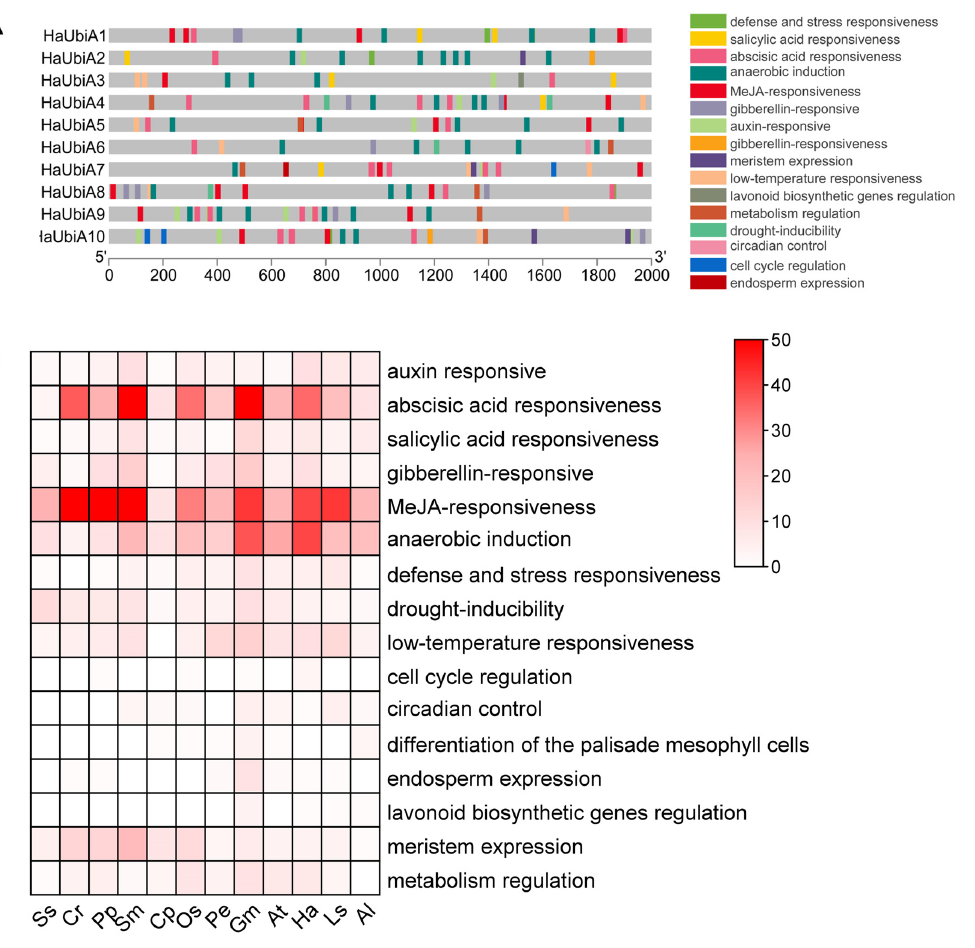
Figure 5. Cis-element analysis of UBiAs promoter. ( A ) Cis-acting elements of UBiA genes promoters in H. annuus. The part in grey were 2000 bp upstream from UBiAs . ( B ) Cis elements of UBiA promoters in the selected 12 species were collected and classified. The number of each element was indicated by the depth of the red color. Ss— Synechocystis ; Cr— Chlamydomonas reinhardtii ; Pp— Physcomitrium patens ; Sm— Selaginella moellendorffii ; Cp— Cycas revoluta ; Os— Oryza sativa ; Pe— Phalaenopsis equestris ; Gm— Glycine max ; At— Arabidopsis thaliana ; Ha— Helianthus annuus ; Ls— Lactuca sativa ; Al— Arctium lappa.